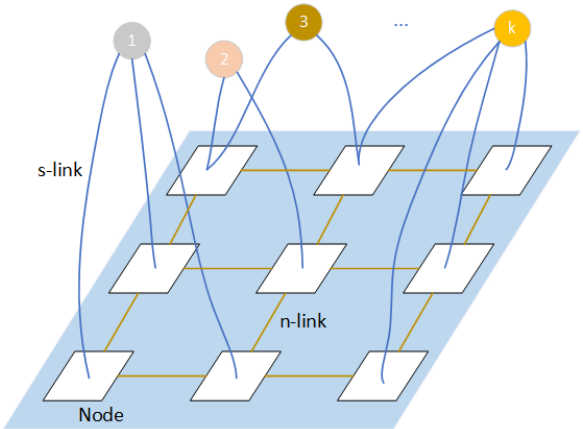
Figure 3. Schematic diagram of multi-label graph cut.